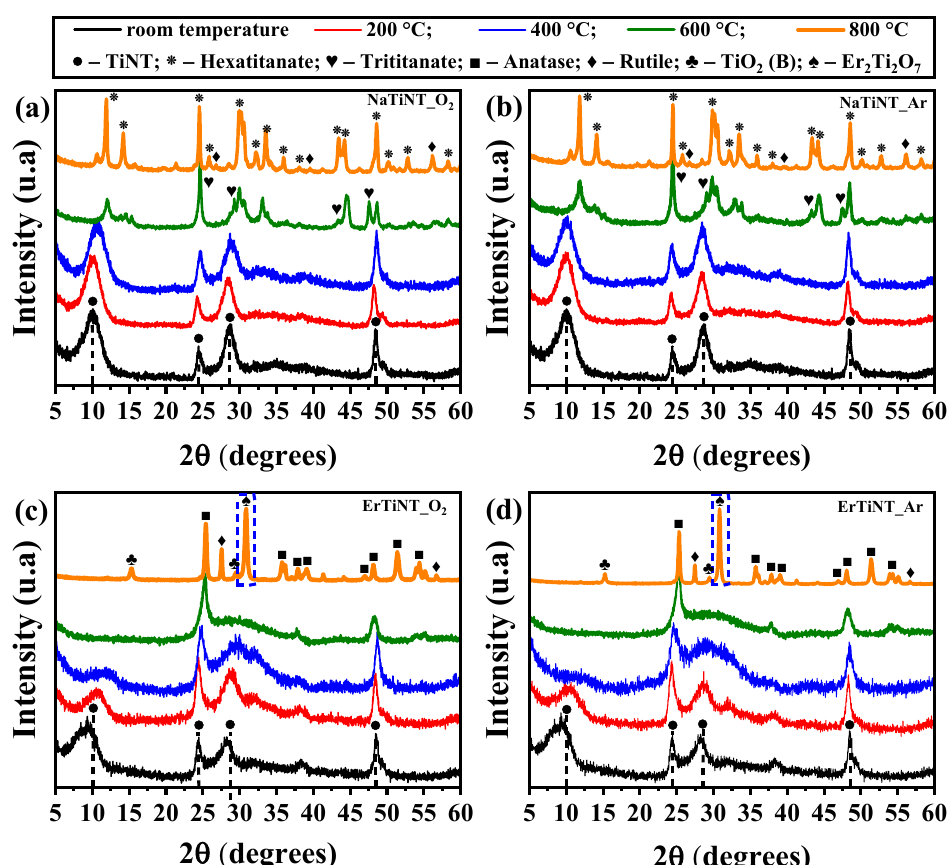
Figure 2. XRD diffractograms of NaTiNTs and ErTiNTs heat treated in air (O 2 ), Figures ( a ) and ( c ), respectively, and argon atmospheres, Figures ( b ) and ( d ), respectively. The dashed lines show the characteristic peaks of the TiNTs, and the symbols indicate the phases observed during thermal treatment at different temperatures. The dashed rectangles highlight the peak related to the erbium oxide formed. The upper caption is the same for all samples.